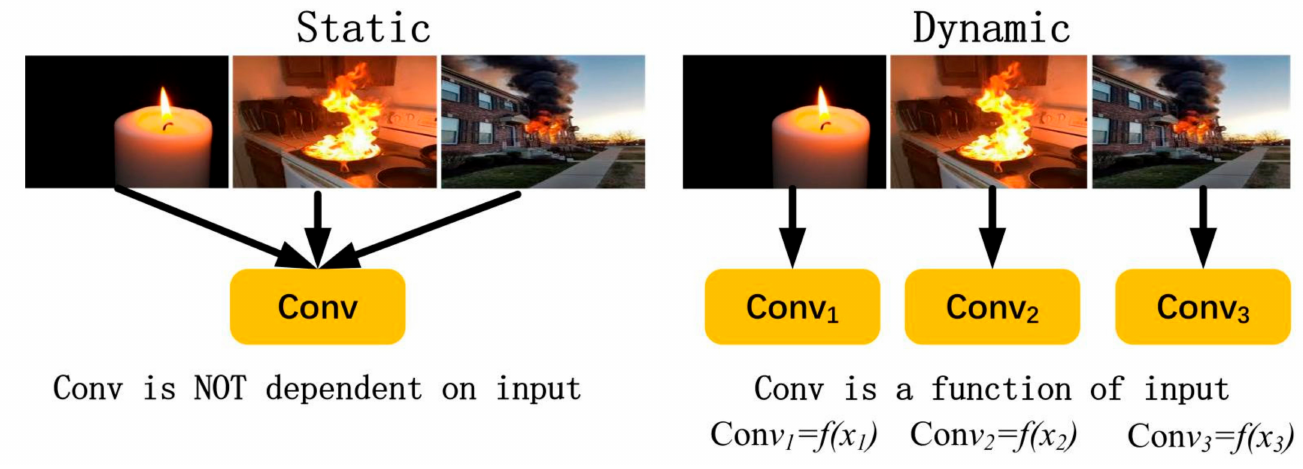
Figure 1. Static and dynamic